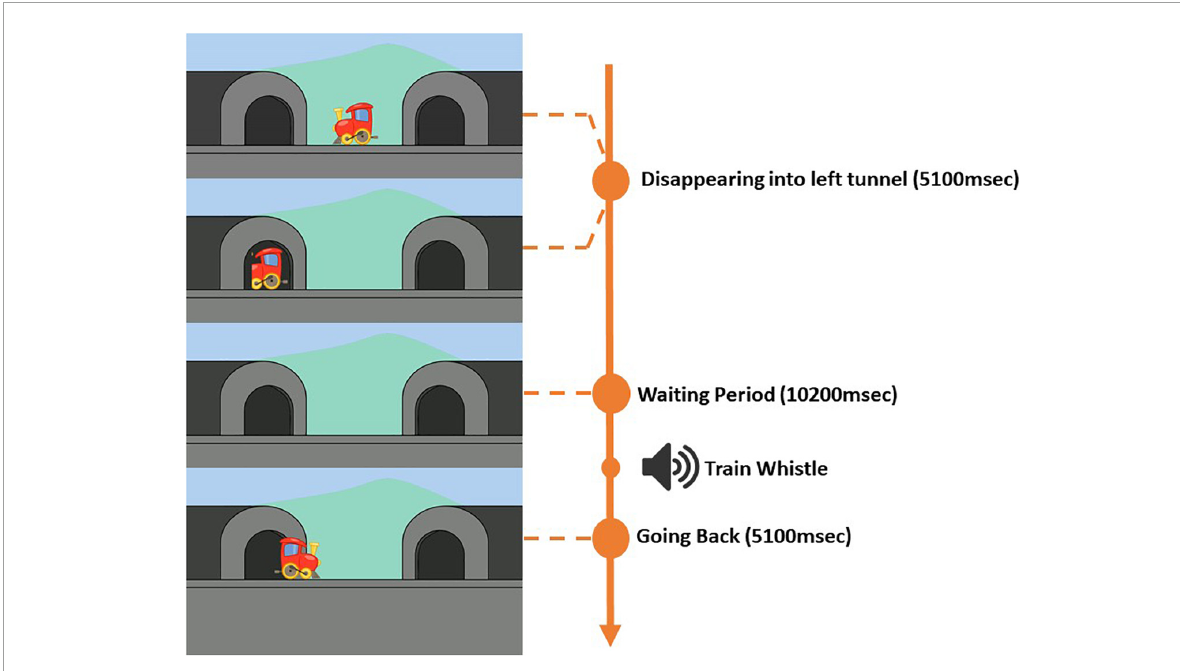
FIGURE1 Progression of the A Trial.